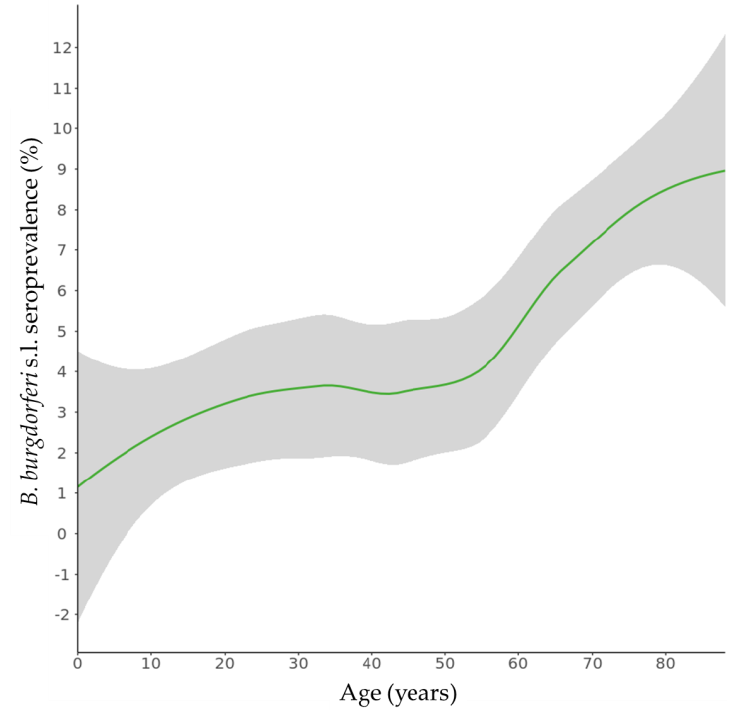
Figure 2. Smooth age-specific seroprevalence of B. burgdorferi sensu lato (s.l.) antibodies in the general population of The Netherlands. Grey areas indicate 95% confidence intervals.